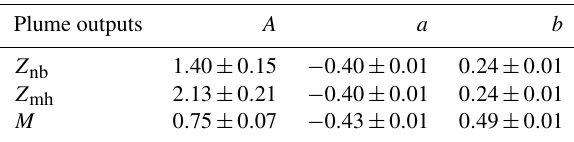
Figure 10. Conservative temperature ( (cid:50) ) and absolute salinity ( S A ) of Saqqarleq Fjord waters in (a) July 2012 and (b) July 2013. Light points show CTD measurements, while dark dots are xCTD mea- surements (closest to the plume). Conservative temperature and ab- solute salinity at the NBD and MHD as predicted by the plume model are shown as a yellow star and triangle, respectively. The solid blue circles represent the water properties in the core of the observed jets in Fig. 7. Table 1. Results of fitting plume outputs to Eqs. (2) and (4). The plume outputs presented here are the characteristic plume heights at neutral buoyancy ( Z nb ) and maximum extent ( Z mh ) and the verti- cally integrated submarine melt rates from the source to the neutral buoyancy height ( M